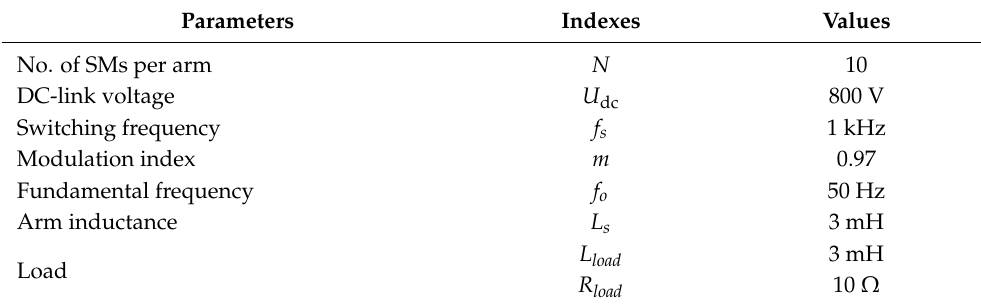
Table 3. Simulation parameters.